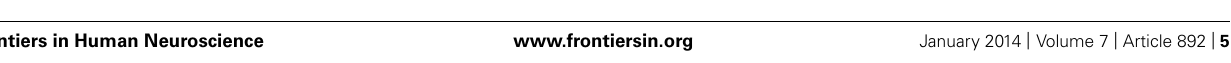
Frontiers in Human